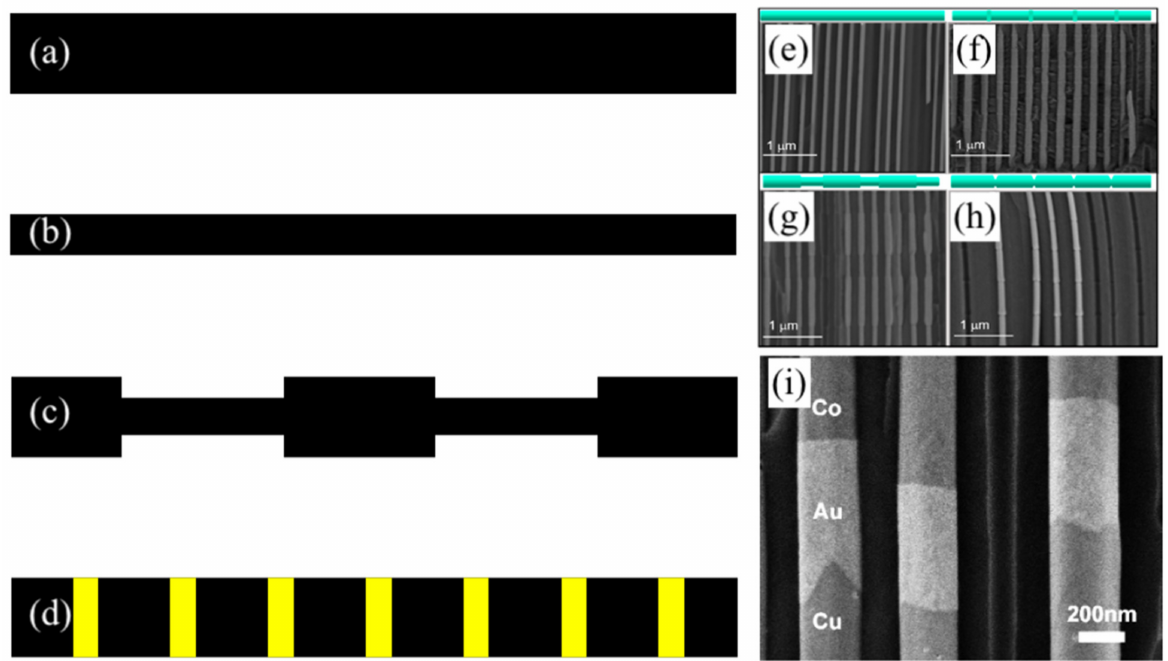
Figure 4. Illustrating the different techniques for tailoring the coercivity of the MNWs, where ( a , b ) changing the diameter (or aspect ratio) of single diameter MNWs; ( c ) modulated diameter MNWs; ( d ) multi-segmented MNWs; ( e – h ) SEM images of varying and modulating the MNWs diameter, adapted from [95]; and ( i ) a SEM image of multi-segmented MNWs, adapted from